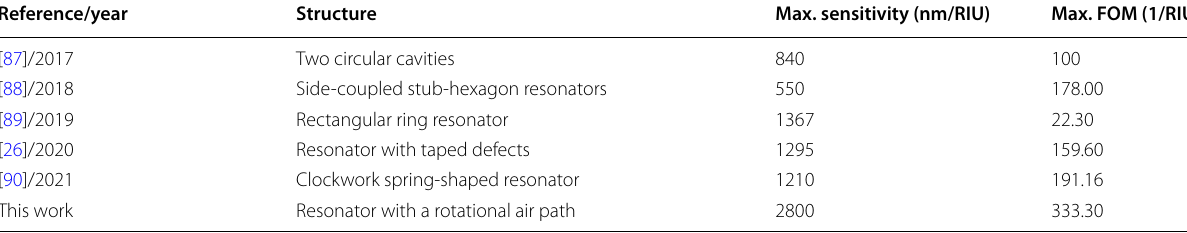
Table 5 Comparison of the sensitivity and FOM between this work and previous similar works Reference/year